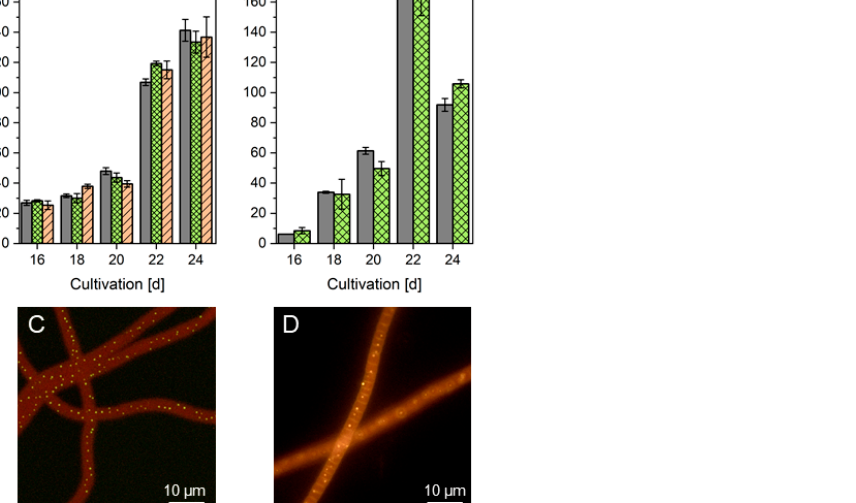
Figure 3. Fluorescent detection and bioimaging of PHB in Leptolyngbya sp. NIVA-CYA 255. PHB levels as revealed by the HPLC (solid bars, grey), LipidGreen2 (crossed bars, green), and Nile red (dashed bars, orange) of BG 11N − ( A ) and BG 11NP − cultures ( B ). Data are the mean ± SD of three repli- cates. PHB granule bioimaging by LipidGreen2 ( C ) and Nile red ( D ).